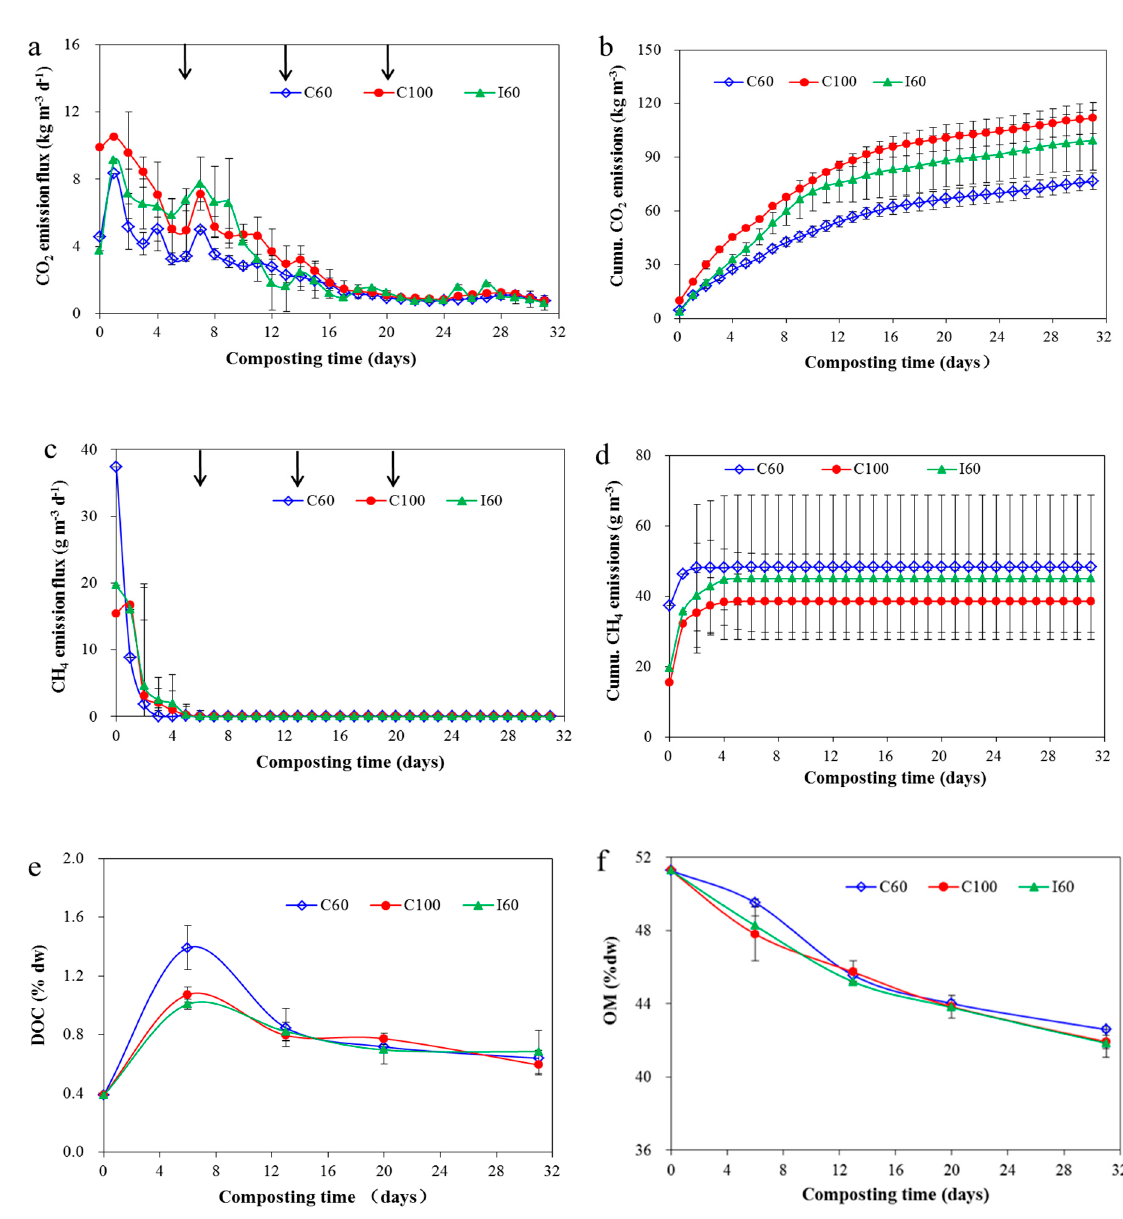
Figure 4. Change of CO 2 ( a ), cumulative CO 2 ( b ), change of CH 4 ( c ), cumulative CH 4 ( d ) emissions, change of DOC ( e ) and change of OM ( f ) during composting. Results are the mean of three replicates and error bars indicate standard deviation. Arrows indicate the time of turning. For abbreviations see Figure 1.